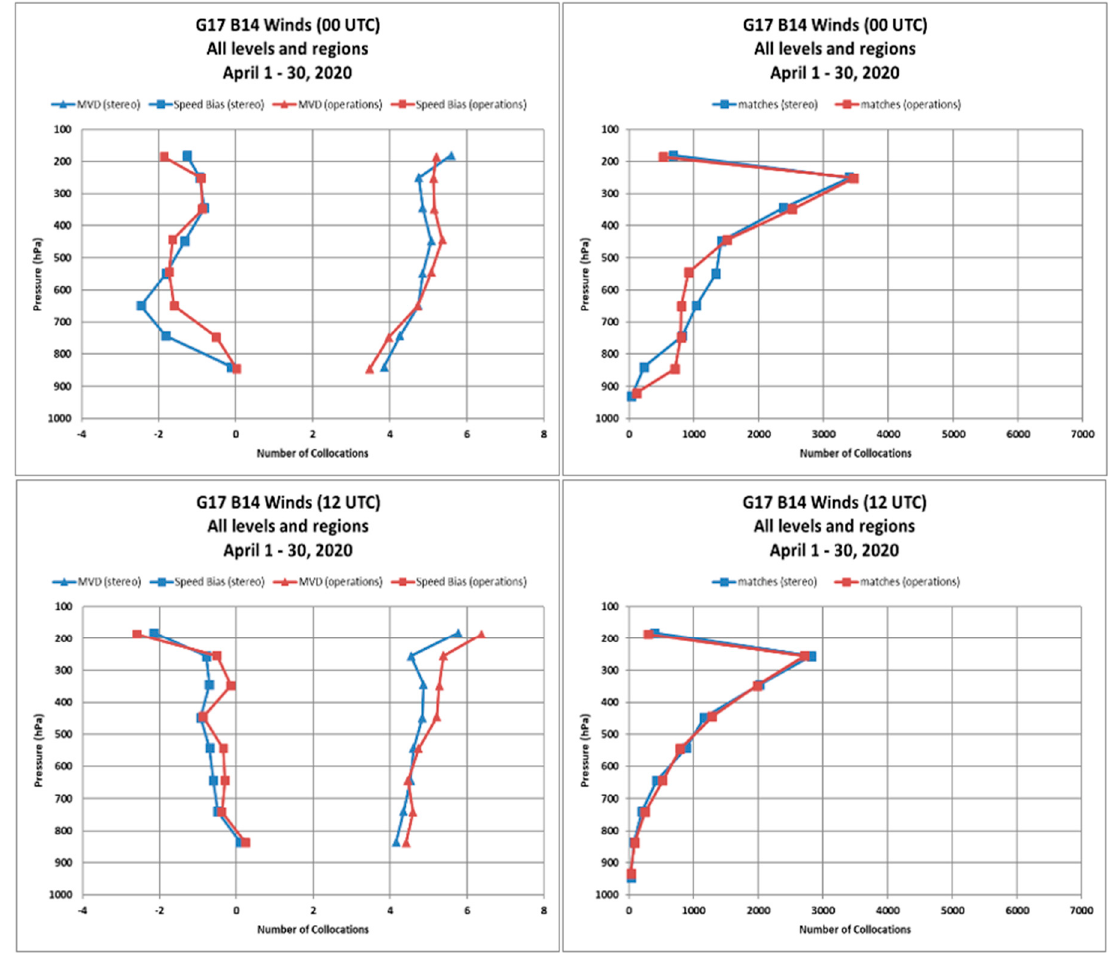
Figure 9. Vertical profiles of the mean vector difference (MVD; triangles) and speed bias (satellite wind minus rawinsonde wind as squares) for GOES-17/16 stereo winds (blue) and NOAA operational winds (red) at 00 and 12 Z for 1–30 April 2020 are shown in the left-hand panels. The corresponding number of collocations is shown in the right-hand panels.